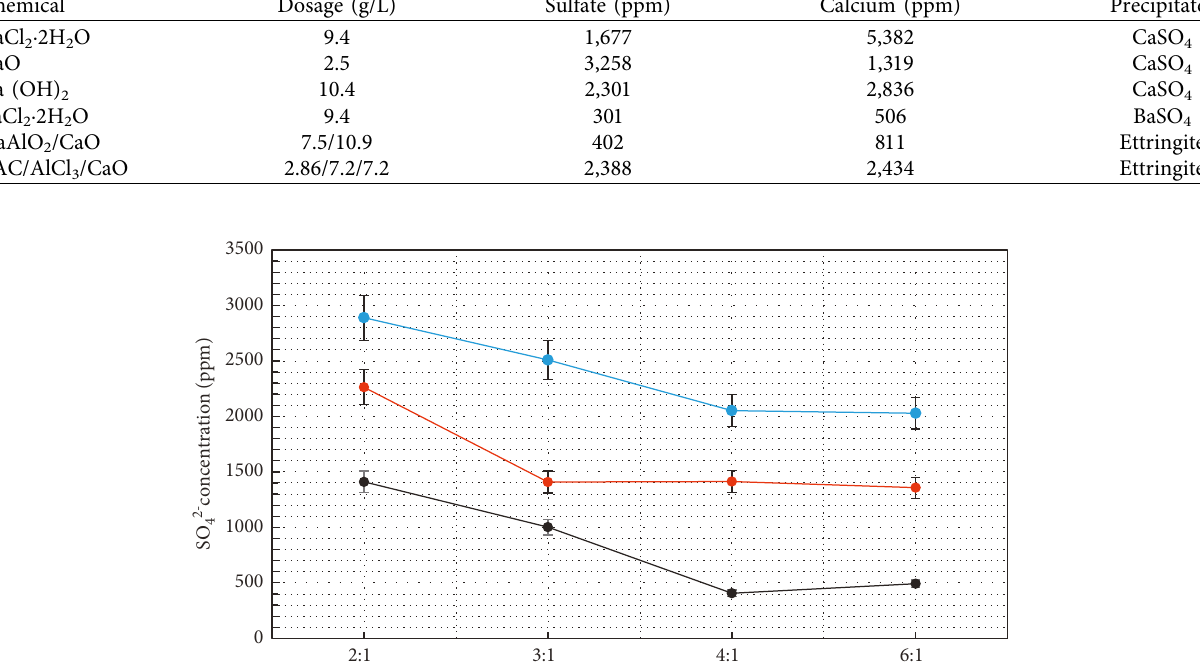
Table 2: Sulfate and calcium concentrations in treated seawater by using CaSO Chemical